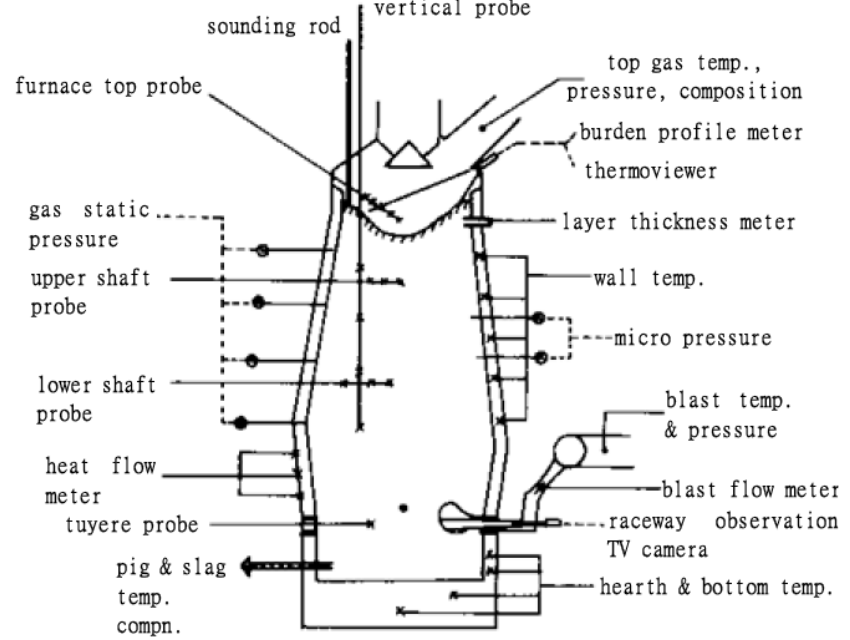
Figure 5. Instrumentation of blast furnaces built after the dissection works Reproduced with permission from [4], Springer, 1987.